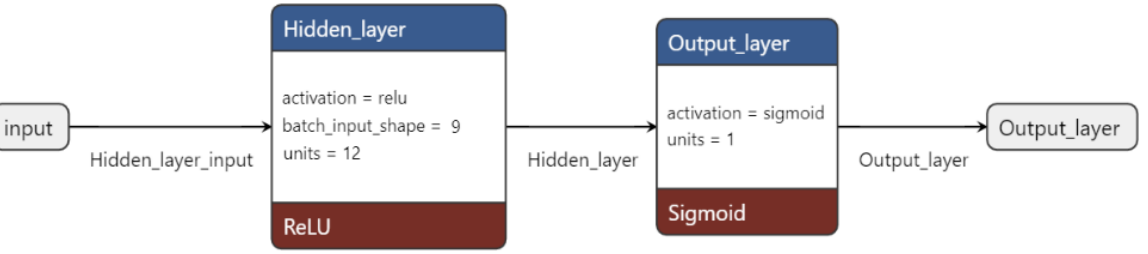
Figure 5. The diagram illustrates the architecture of the neural network. The input layer is represented by the gray square, with the hidden and output layers depicted in blue. The activation functions used are indicated in red. The number of units per layer is specified within each respective square.